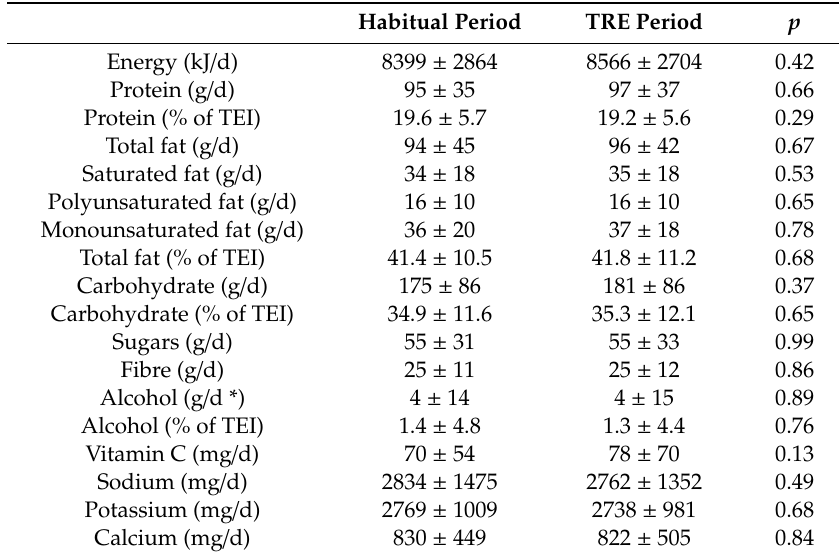
Table 2. Overview of dietary intake for Habitual (13.8 ± 0.4 days) vs. time-restricted eating (TRE; 27.6 ± 1.4 days) periods as assessed from daily dietary food records for individuals with type 2 diabetes and overweight /